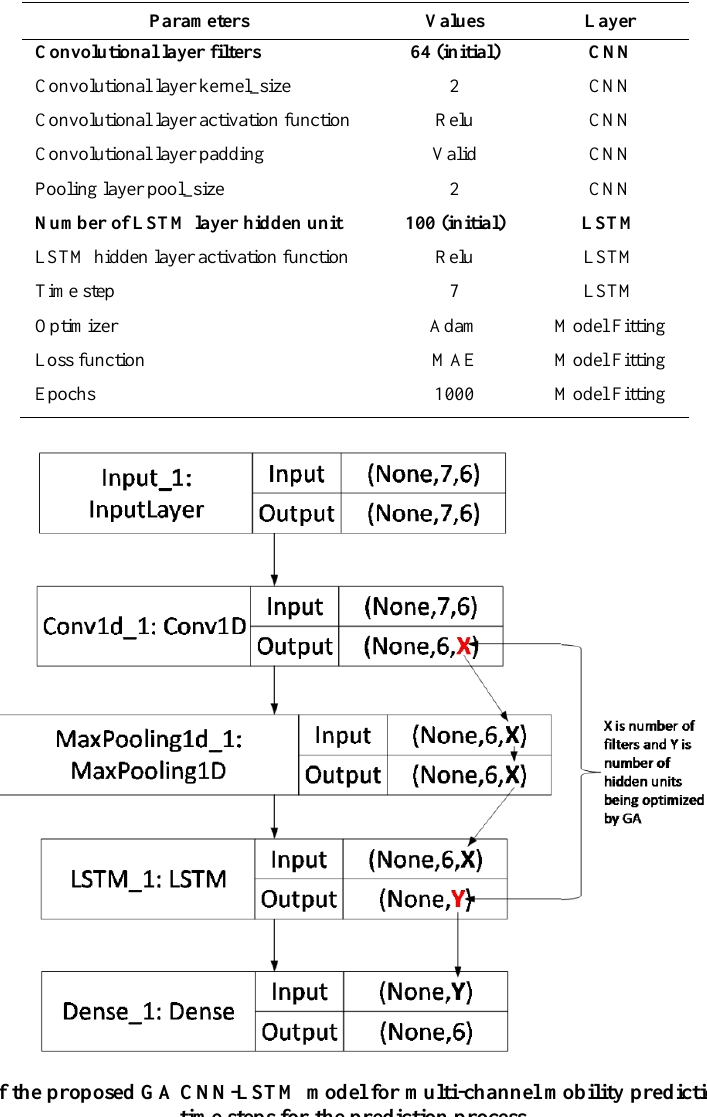
Table 2. Parameters configuration for the proposed GA CNN-LSTM model. The convolutional layer filters and number of LSTM layer hidden unit values are initially set to 64 and 100 and will be optimized by GA throughout learning process.